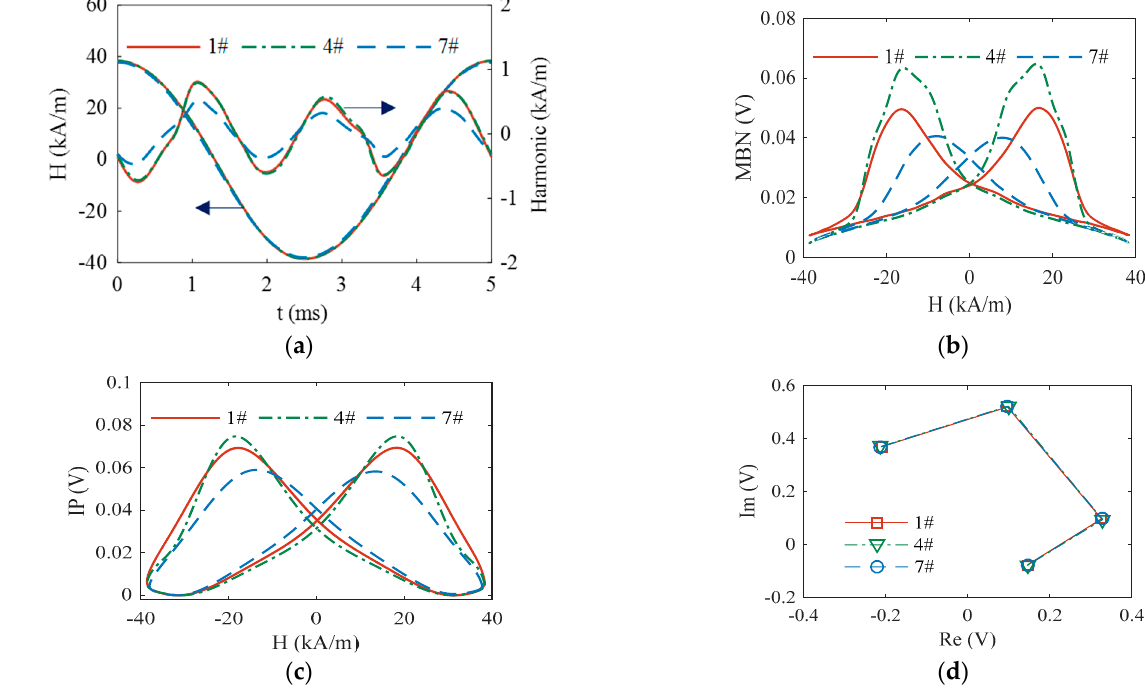
Figure 2. ( a – d ) demonstrate the patterns of TMF, MBN, EIP, and MFEC,